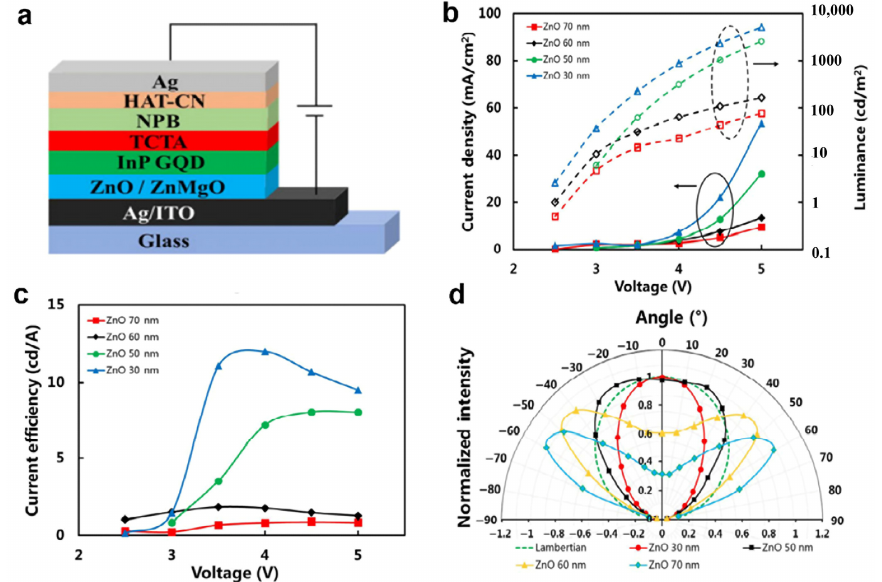
Figure 15. ( a ) Basic device structure of InP QLED. Performance of the top-emission QLEDs: ( b ) J − V − L characteristics and ( c ) current efficiency curves with different ZnO ETL thickness. ( d ) The measured normalized angle − dependent EL intensity of the top-emission QLEDs with different ZnO ETL (the HTL thickness is 30 nm). Reprinted with permission from Ref. [110]. © 2021, Tsinghua University Press and Springer − Verlag GmbH Germany, part of Springer Nature.